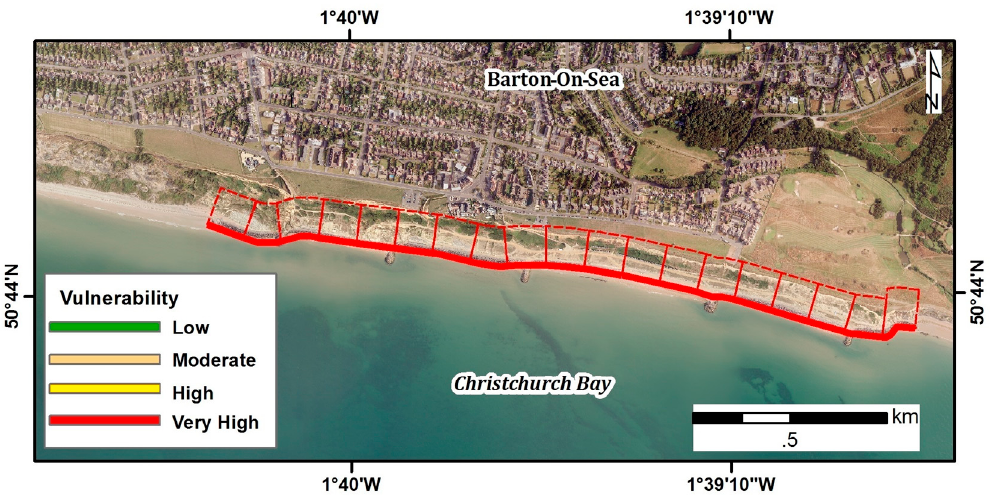
Figure 7. Coastal vulnerability map.